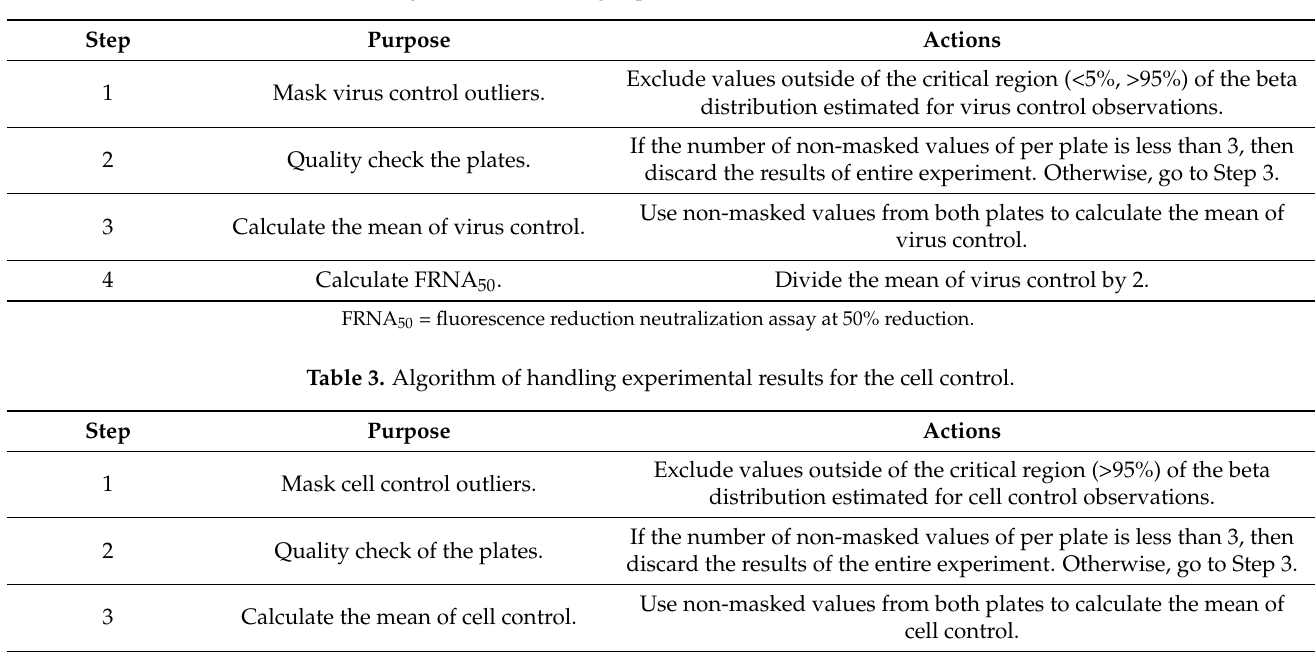
Figure 8. A histogram of the cell control observations (Figure 7) after outliers were removed. When more than three values per plate (out of six) were outside of the acceptable region, it was recommended to discard results of the entire experimental run (both plates). Using a tailored algorithm to handle experimental results (Tables 2 and 3), only one out of 15 runs was qualified as having faulty controls. Table 2. Algorithm of handling experimental results for the virus control.